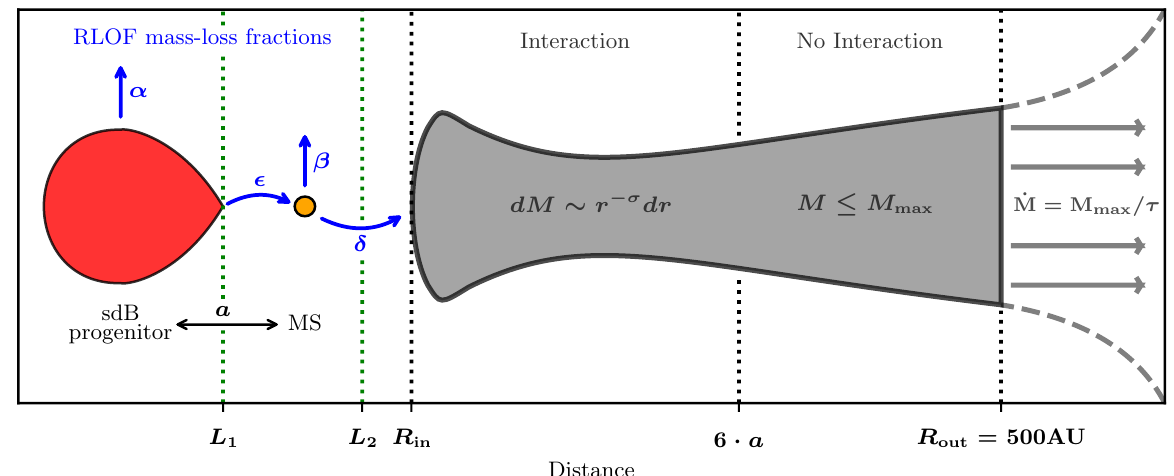
Figure 2. The Roche-lobe overflow model used in MESA, including the formation of a circumbinary disk.